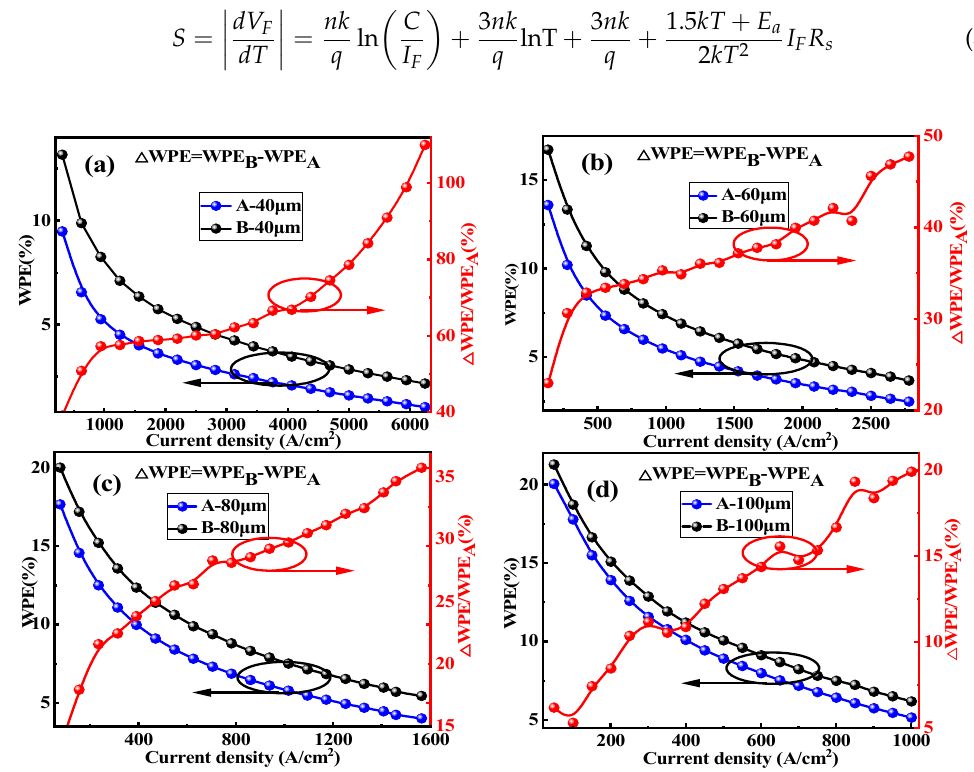
Figure 3. WPE vs. current densities of Micro LED A and B ( a ) 40 μ m ( b ) 60 μ m ( c ) 80 μ m ( d ) 100 μ m.